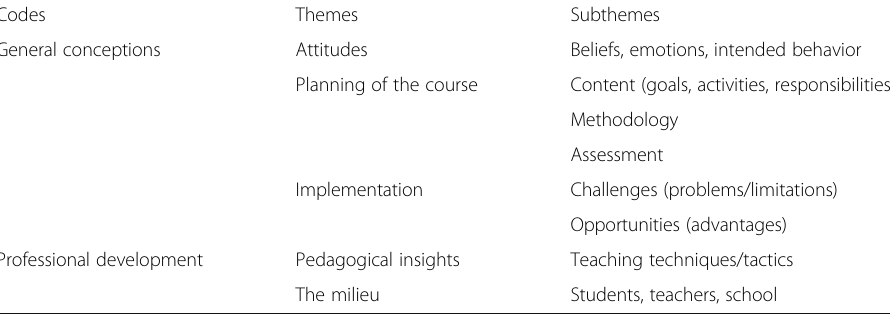
Table 8 The coding scheme of STs ’ conceptions of professional development during